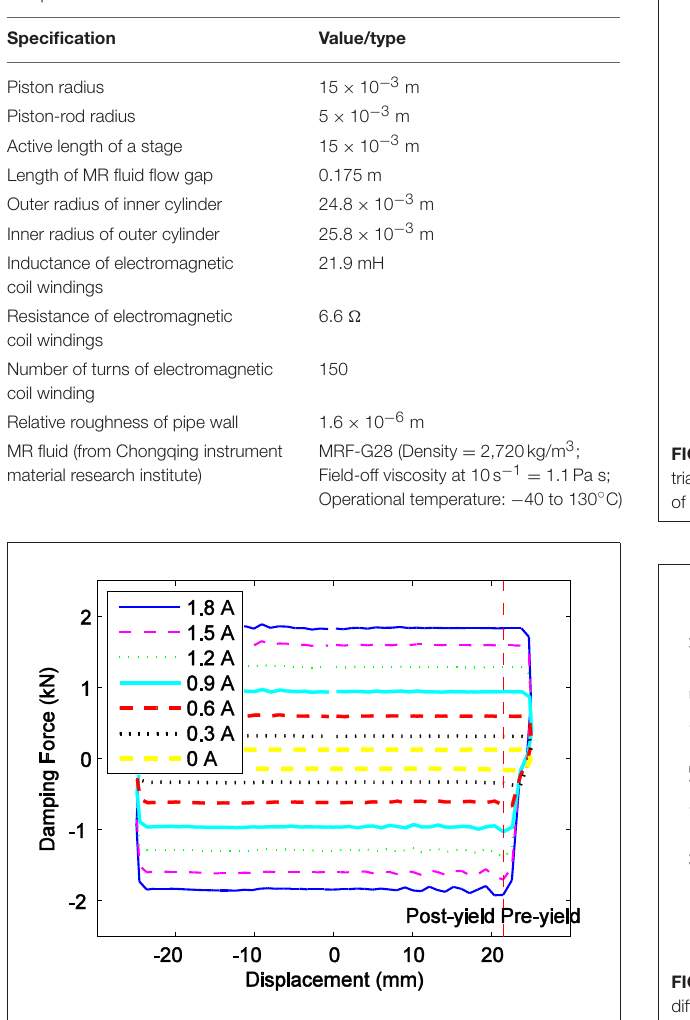
FIGURE 2 | Mechanical behavior of the MR damper with different currents under triangle displacement excitation with a frequency of 1Hz and an amplitude of 25mm.